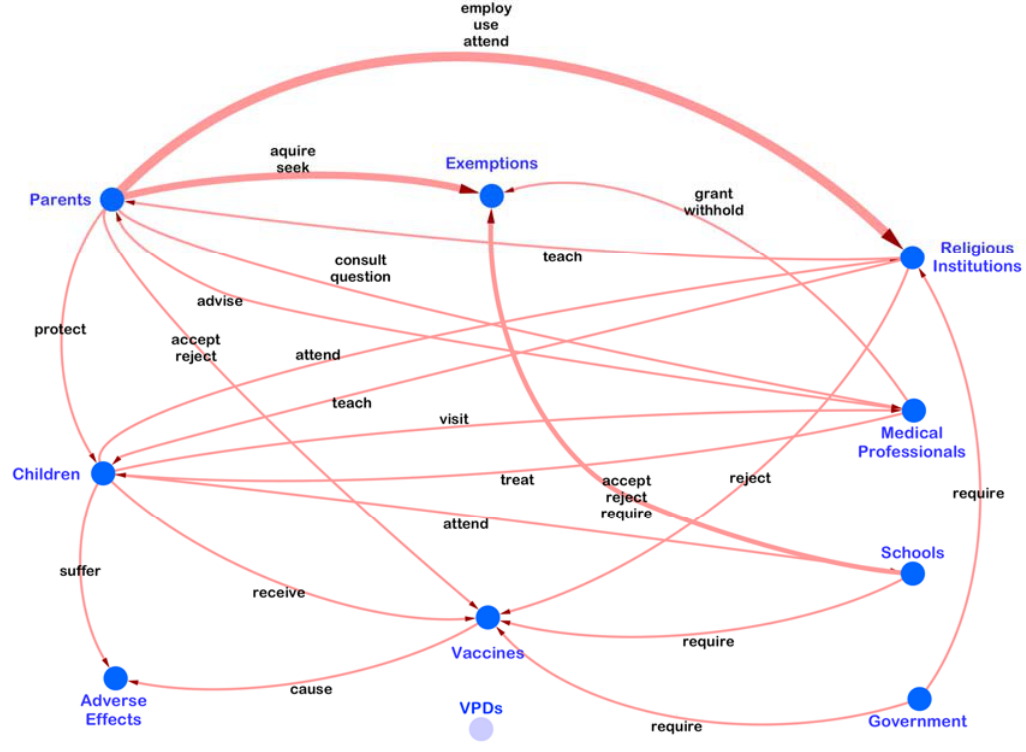
Figure 4. A visual representation of the actants and their relationships in the “Vaccine Exemption” domain in the traditions of two online parent communities (Tangherlini et al. 2016).